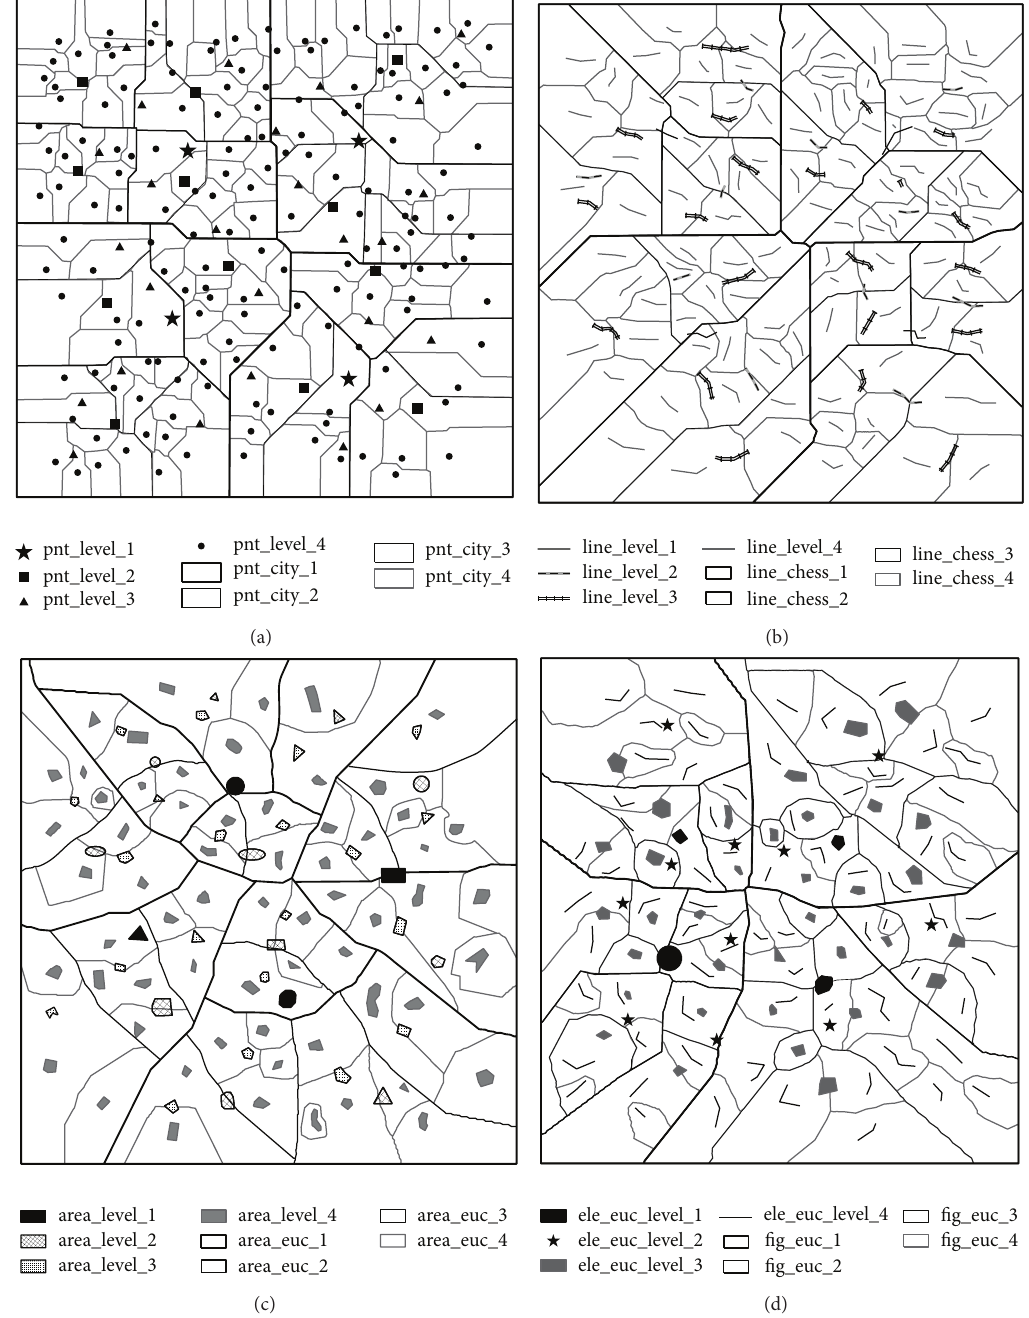
Figure 4: Different types of SVTs. (a) An ordinary SVT for points based on the Manhattan metric; (b) an ordinary SVT for lines based on Chessboard metric; (c) a weighted SVT for polygons based on the Euclidean metric; (d) a weighted SVT for points, lines, and polygons based on the Euclidean metric.